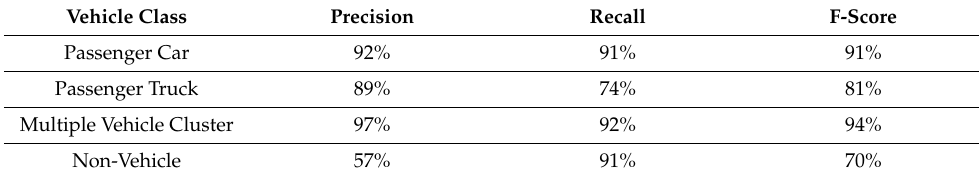
Table 7. Different evaluation metrics for the detected classes within Video